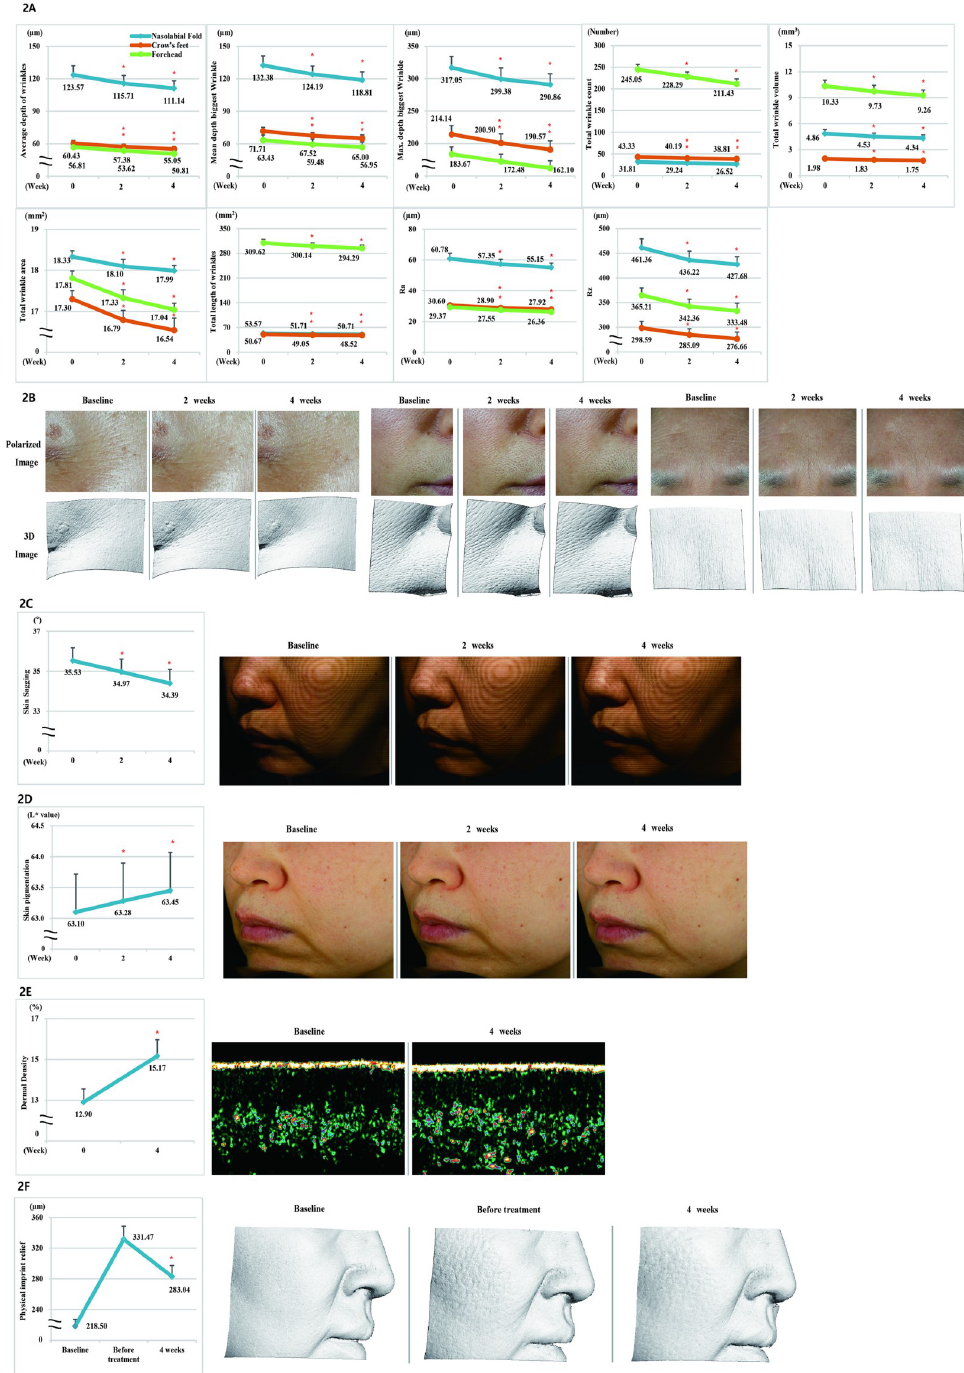
Fig 2. (A) Collagen and ascorbic acid have beneficial effect on skin aging. (B) Fluorescence imaging of fibroblasts, keratinocytes, and melanocytes in the control and test groups at × 400 (Scale bar = 20 μ m) and × 1000 (Scale bar = 5 μ m) magnification. (C) fluorescence imaging of a cross-section of human skin tissue in the control and test groups ( × 400, Scale bar = 50 μ m, n = 20). (D) Analysis of collagen synthesis depending on the concentration of the test product (n = 4, ��� p <